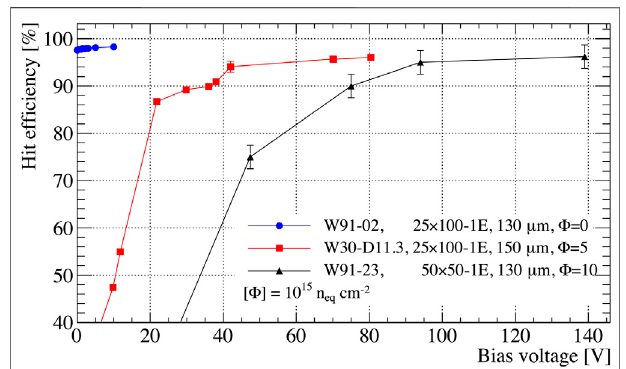
FIGURE 11 | Hit ef fi ciency as a function of the bias voltage for RD53A modules with SINTEF 3D sensors from run four before and after irradiation. The sensors have a 50 × 50 − 1E pixel geometry. For better visibility the data of D61-2 before irradiation (black circles) is shifted by − 1